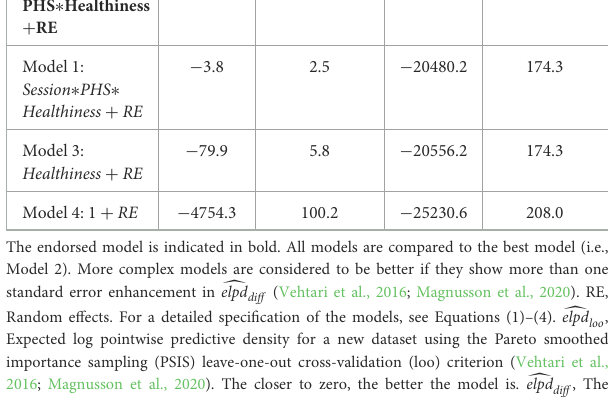
TABLE 2 Fit indices of the choice models computed by multilevel Bayesian generalized linear modeling (ordered by fit). Choice